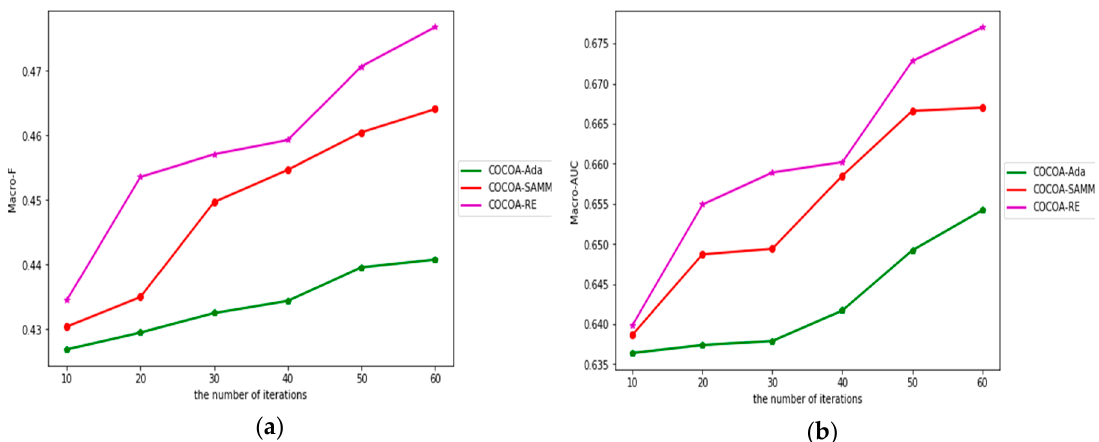
Figure 6. The results with changing iterations using neural network as the binary-class classifier: ( a ) The Macro-F values of comparable approaches in different iterations; ( b ) the Macro-AUC values of comparable approaches in different iterations.